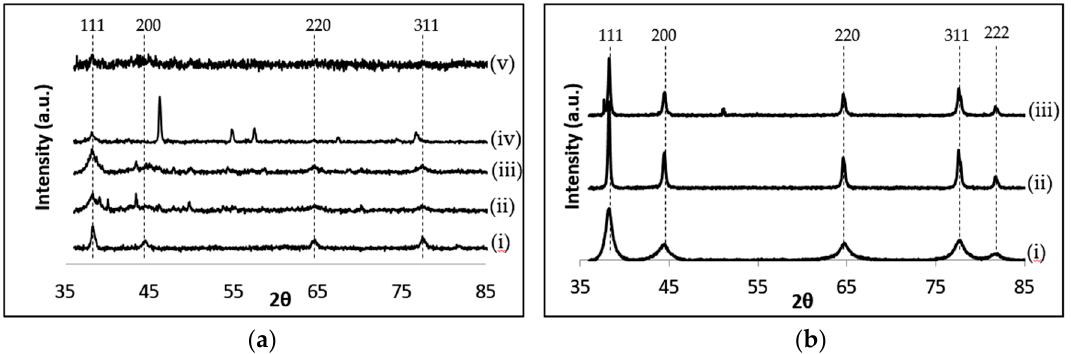
Figure 9. XRD patterns obtained for ( a ) the AgNPs synthesised using (i) sodium borohydride; (ii) AC extracts; (iii) AR extracts; (iv) Mp fucoidan and (v) Fv fucoidans; and ( b ) the AuNPs synthesized using (i) sodium citrate; (ii) AC extracts and (iii) AR extracts. AC: Aqueous extract subjected to organic